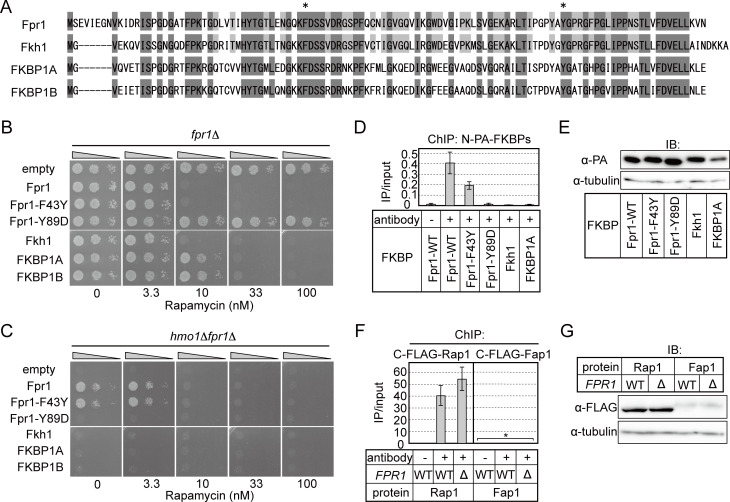
Effect of mutations of Fpr1 on its functions.(A) Alignment of Fpr1 and its orthologues from other species. Amino acids highlighted in dark grey are conserved among Fpr1, Fkh1 (S. pombe), FKBP1A (human), and FKBP1B (human). Amino acids highlighted in pale grey are conserved between Fpr1 and Fkh1. (B) WT or mutant Fpr1 proteins (F43Y, Y89D) or Fpr1 orthologues from other species were expressed in fpr1Δ cells (YKK207 cells harbouring plasmids expressing Fpr1WT (pKM738), Fpr1F43Y (pKM769), Fpr1Y89D (pKM788), Fkh1 (pKM774), FKBP1A (pKM794), or FKBP1B (pKM785)). The resulting strains were spotted onto SD plates containing or not containing rapamycin as indicated, and grown at 30°C for 3 days. (C) The activity of Fpr1 proteins or Fpr1 orthologues in enhancing hmo1Δfpr1Δ cell growth was examined. This activity should reflect the function of the proteins in promoting the transcription of Fpr1-target genes. The same proteins as in (B) were expressed in hmo1Δfpr1Δ cells (YKK206), and the resulting strains were spotted onto SD plates containing or not containing rapamycin as indicated, and grown at 30°C for 4 days. (D) ChIP analysis of DNA binding of Fpr1 proteins and orthologues. The strains used in (B) were subjected to ChIP assays using anti-PA-tag antibody. (E) Extracts prepared from yeast cells used in (D) were immunoblotted with anti-PA-tag or anti-α-tubulin antibody (loading control). (F) ChIP analysis of DNA binding of Fap1. Strains expressing C-terminally FLAG (3×)-tagged Fap1 were subjected to ChIP assays using anti-FLAG-tag antibody. The same experiment was conducted for strains expressing C-terminally FLAG (3×)-tagged Rap1 as a control (FAP1-FLAG: YKK792; FAP1-FLAG fpr1Δ: YKK794; RAP1-FLAG: YKK1074; RAP1-FLAG fpr1Δ: YKK1072). Asterisks: DNA-binding values of Fap1 are less than 0.1 (IP/input) when calculated using the same method as for Rap1. (G) Extracts prepared from yeast cells used in (F) were immunoblotted with anti-FLAG-tag or anti-α-tubulin antibody as in (E).